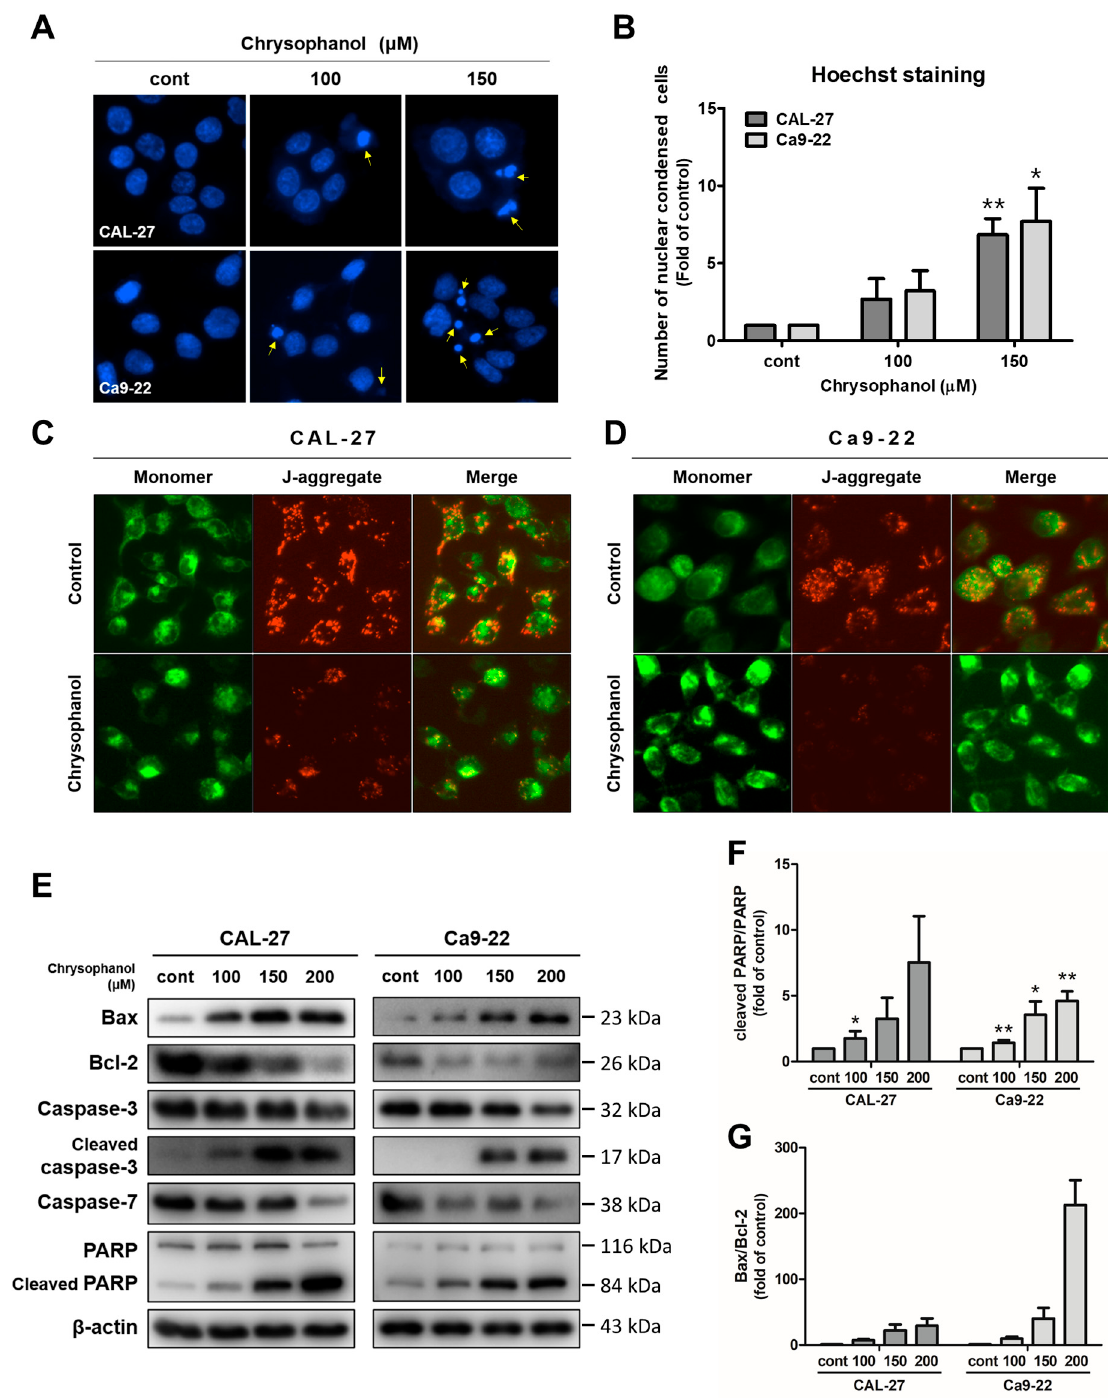
Figure 3. Chrysophanol induced apoptosis via caspase activations in CAL-27 and Ca9-22 cells. Both cells were incubated with chrysophanol (0, 100, and 150 μ M) for 24 h. ( A , B ). The change in nuclear morphology was investigated by Hoechst agents. Then, nuclear condensation was converted into proportions to control the process and is shown in a histogram. ( C , D ) After the treatment of 200 μ M chrysophanol, the mitochondrial membrane potential ( ΔΨ m) was measured by JC-1 solutions. ( E ) Western blot analysis was used to identify the expression level of proteins which affect cell apoptosis, such as Bax, Bcl-2, caspase-3, caspase-7, and PARP. β -actin was used to present a loading control. ( F , G ) The relative protein, cleaved PARP/PARP, and Bax/Bcl-2 density were measured; and the fold change was calculated. Data are expressed as mean ± SD (* p < 0.05, ** p < 0.01).